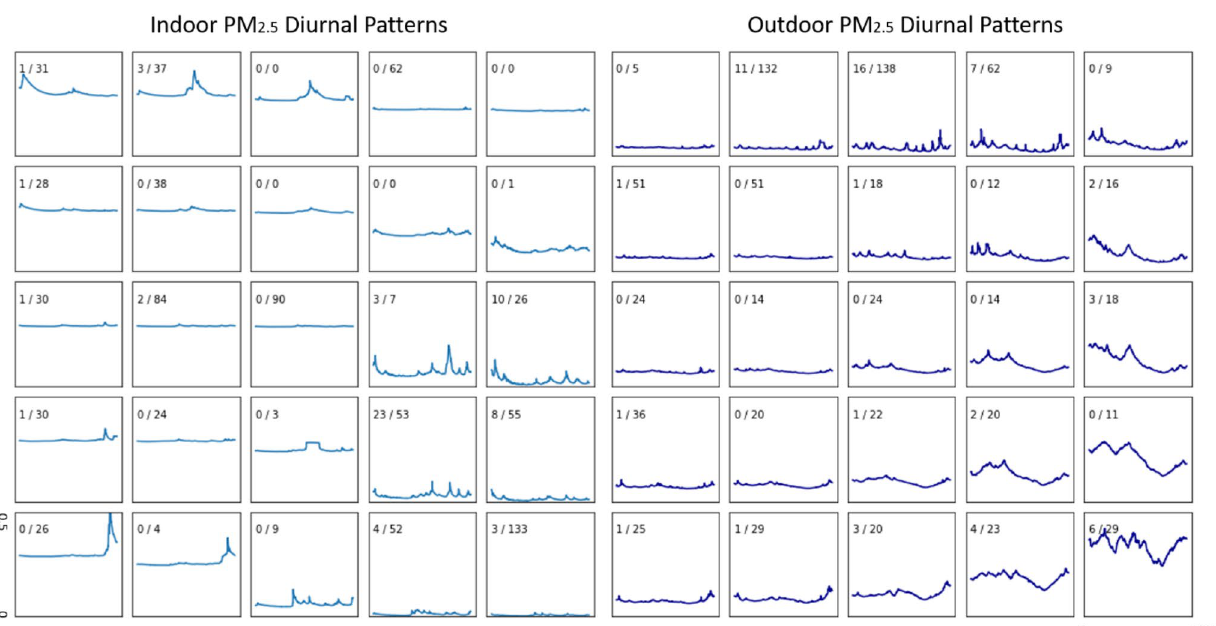
Figure 7. Diurnal patterns in indoor (left) and outdoor (right) residential PM 2.5 identified using DTW-SOM. The fraction in each cell represents the number of days with inhaler usage over the number of days matching the diurnal